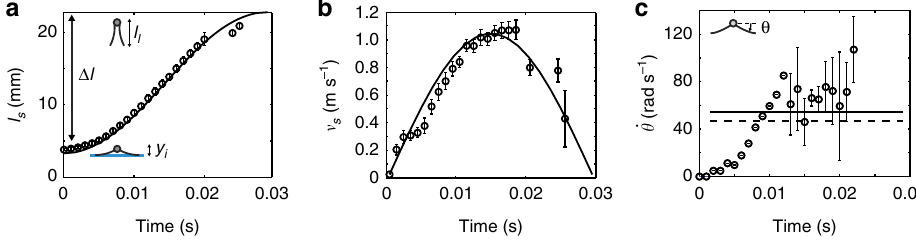
Figure 2 | Comparison of empirical and modelled leg movements. The solid lines correspond to the model assuming the sinusoidal model of leg rotation and the circles correspond to the average of measurement of four legs from the same movie used in Fig. 1e–h. The error bars indicate standard deviation among the four legs. ( a ) The average vertical distance between the body centre and distal end of legs ( l s ) across the leg rotation cycle. ( b ) The average downward velocity of four legs with respect to body centre ( n s ). ( c ) The average time derivative of the angle of legs with respect to the horizontal plane ( _ y ). The dashed line indicates the time average of the measured values of _ y through the whole cycle and the solid line refers to the corresponding angular speed of leg rotation o used in the model calculations of l s and n s in a , b .